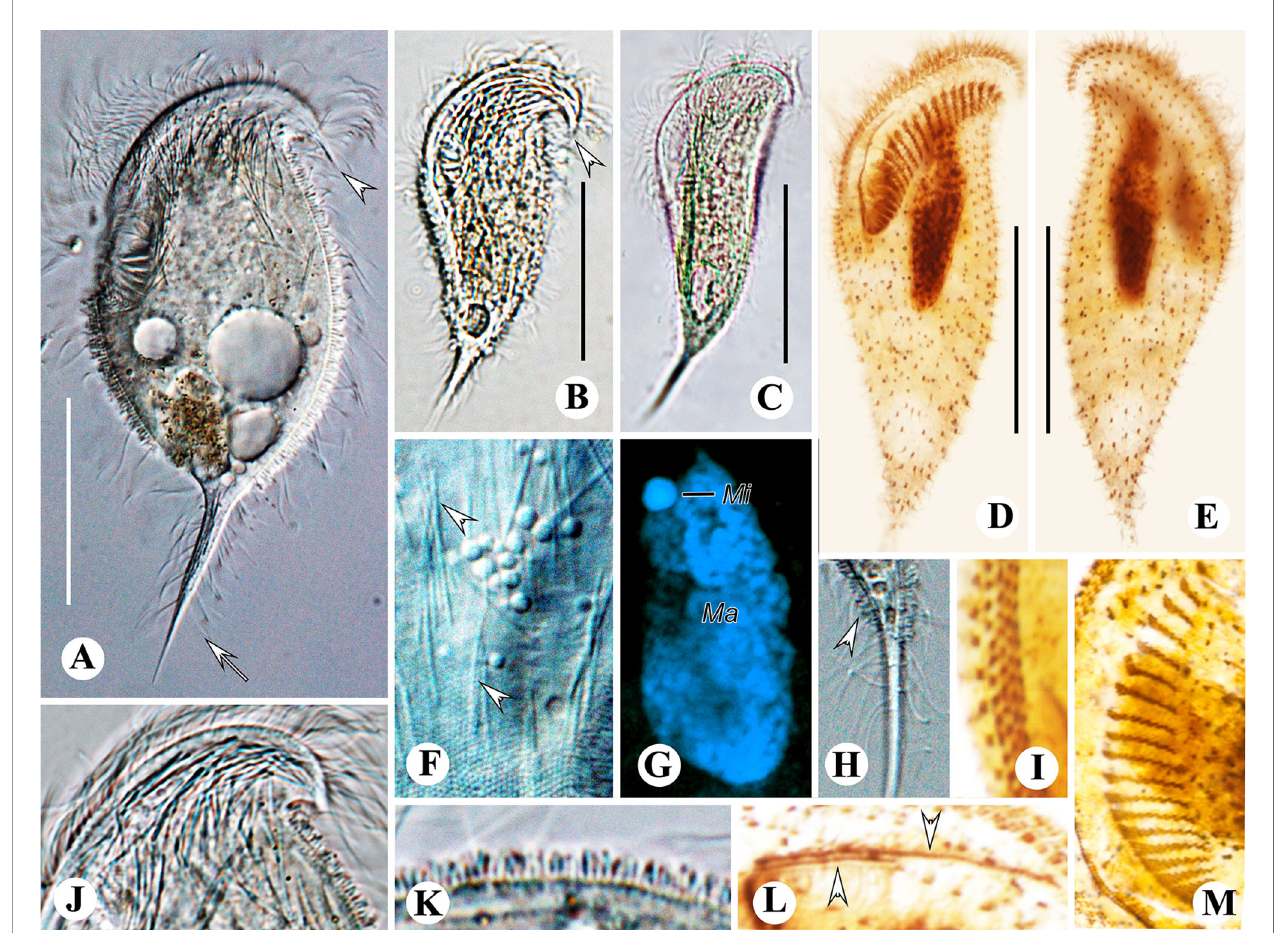
FIGURE 5 | Metopus spiculatus sp. n. from lifewithdifferential interference contrast (A, F, H) illuminations, bright- fi eld (B, C, J, K) , and after DAPI staining (G) and after protargol staining (D, E, I, L, M) . (A – C) Ventralview showing different bodyshapes, arrowheads showing spine of dome, andarrow showing posterior spine. (D, E) Ventral (D) and dorsal (E) views of the holotype showing ciliature and macronucleus. (F) Unidenti fi ed fi liform intracytoplasmicstructures (arrows). (G) Macronucleus andmicronucleus. (H) Posterior spine and ectosymbionts (arrowhead). (I) Perizonal stripe and false kineties. (J) Corticalgranules on preoral dome. (K) Lateral view showing ectosymbionts. (L) Two rows of paroral membrane (arrowheads). (M) Adoral membranelles. Mi, micronucleus; Ma, macronucleus. Scalebars: 35 m m (A, G) and 30 m m (B – E)